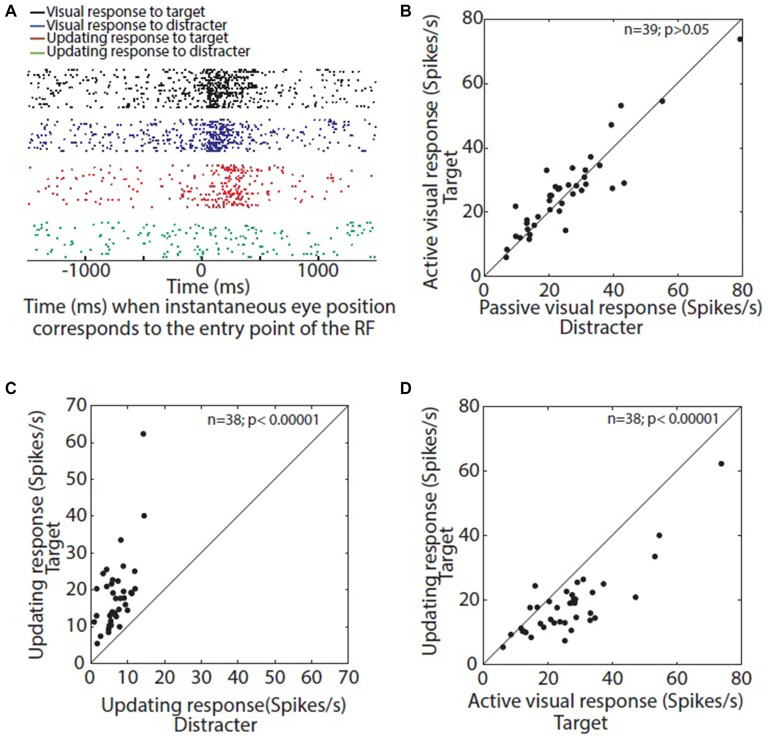
(A) Time aligned raster display of visual and updating response: black and blue raster’s corresponds to visual responses when target or distracter corresponded with entry point of the neuron’s RF, respectively. Red and green raster’s corresponds to updating responses for target and distracter, respectively. (B) Comparison of visual response for target and distracter: average visual response for target is plotted as a function of visual response for distracter. (C) Comparison of updating responses for target and distracter: average updating response for target is plotted as a function of updating response for distracter. All the neurons show a higher updating response for target when compared with that for distracter. (D) Comparison of visual and updating responses for target: average updating response is plotted as a function of average visual response. Almost all the neurons show a higher visual response compared with updating response.